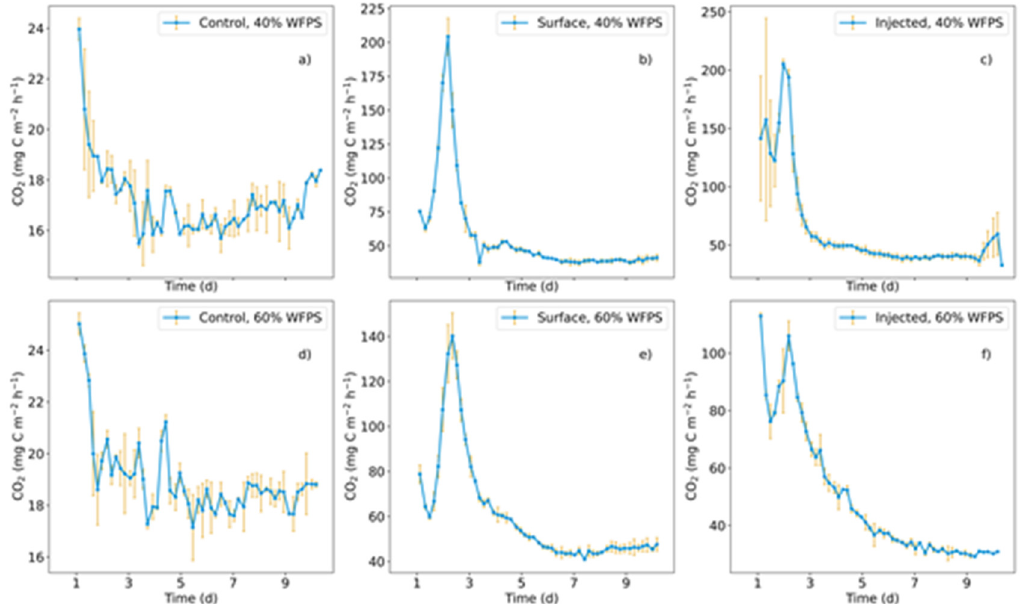
Figure 1. CO 2 fluxes during laboratory incubation of a sandy, arable soil from Fuhrberg, Germany. The water content (40% ( a – c ) and 60% ( d – f ) WPFS) was kept constant during the experiment. Three manure treatments were applied: control (no manure) ( a , d ), surface (manure on the surface) ( b , e ) and injected (manure in the middle layer of the soil core) ( c , f ). The yellow lines represented the standard deviation of the three parallel measurements. The first visualised measurement was taken within 18 h of the soil columns being packed.